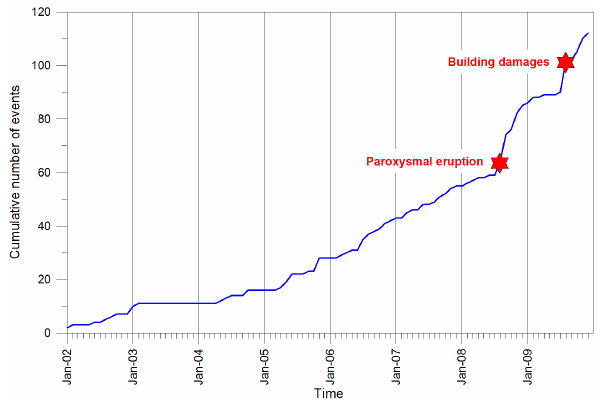
Fig. 13. Cumulative time distribution of the earthquakes recorded in the study area during the observational period; red stars indicate the main paroxysmal events that occurred in 2008 and